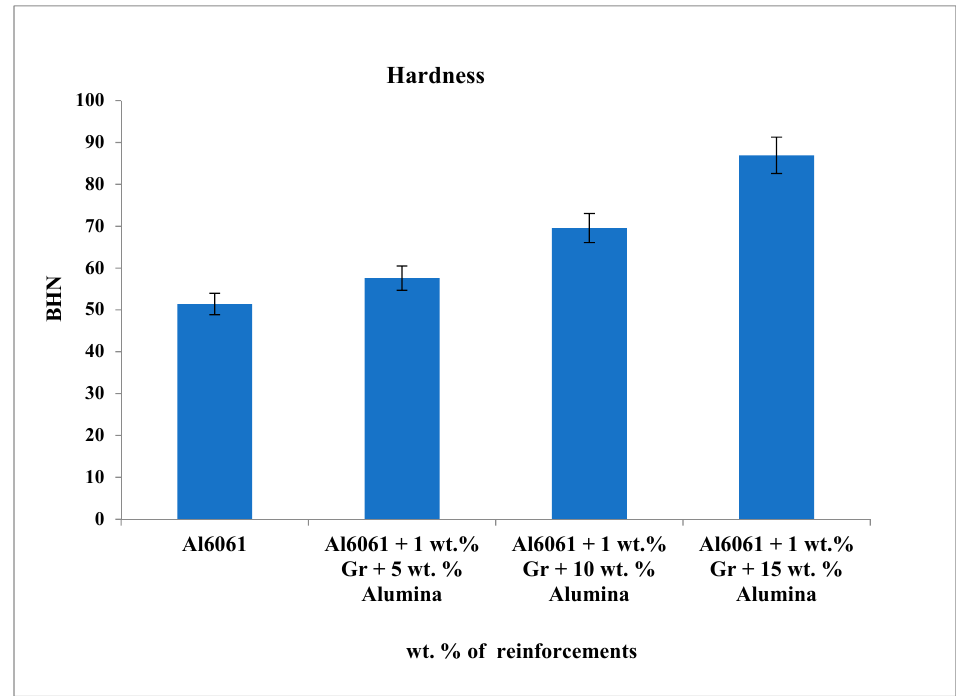
Figure 6. Hardness variation in hybrid Al6061-Al 2 O 3 -graphene composites .